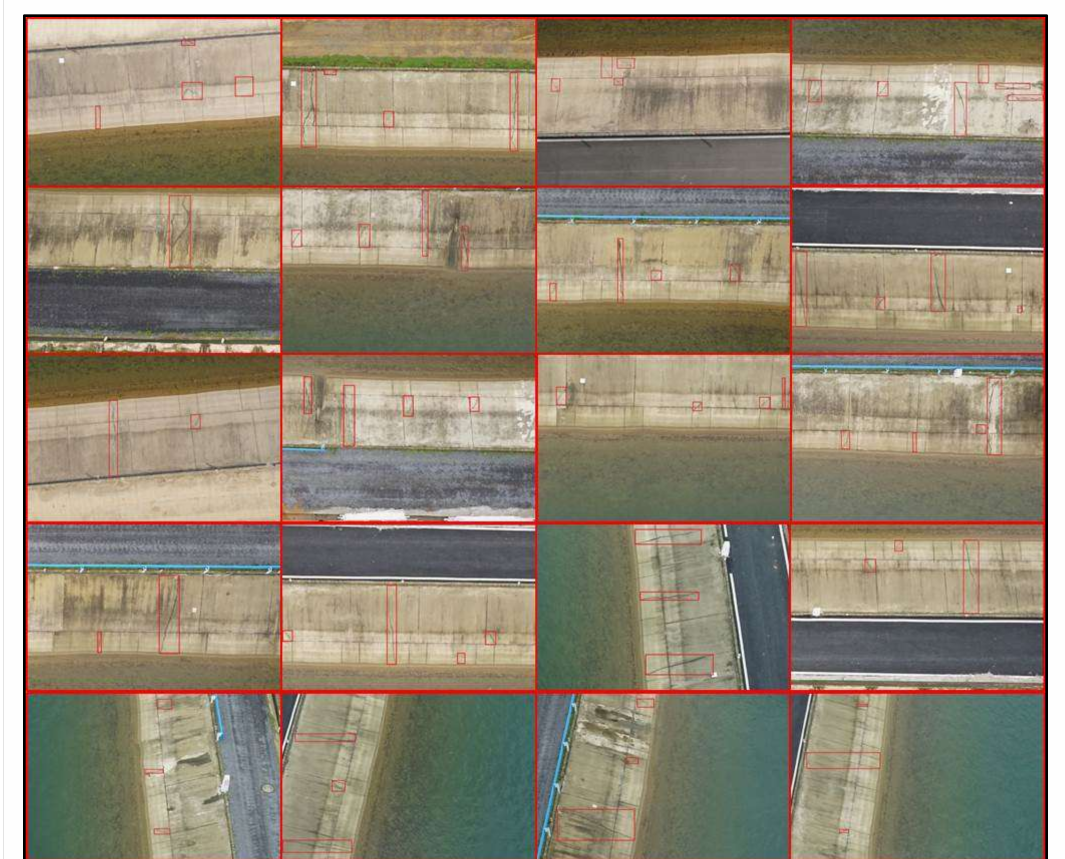
Figure 10. Marking details